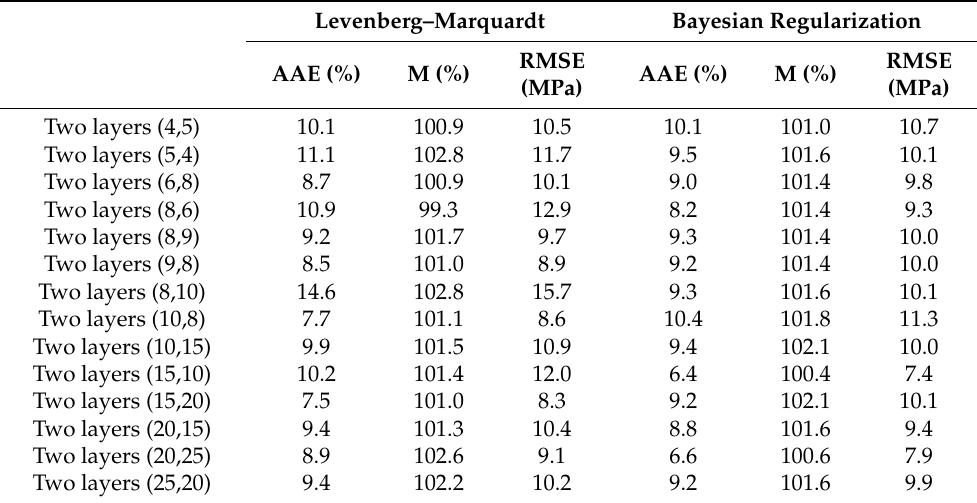
Table 4. Summary of different studied cases for different layers in predicting f’ cc .